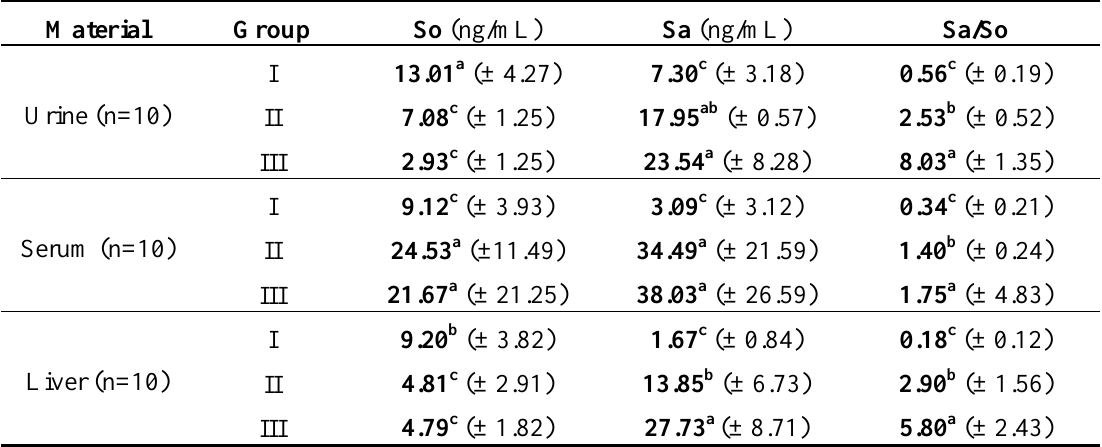
Table 1. Mean sphingosine (So) and sphinganine (Sa) levels and mean Sa/So ratio in urine, liver and serum or rats submitted to prolonged exposure (21 days) to FB